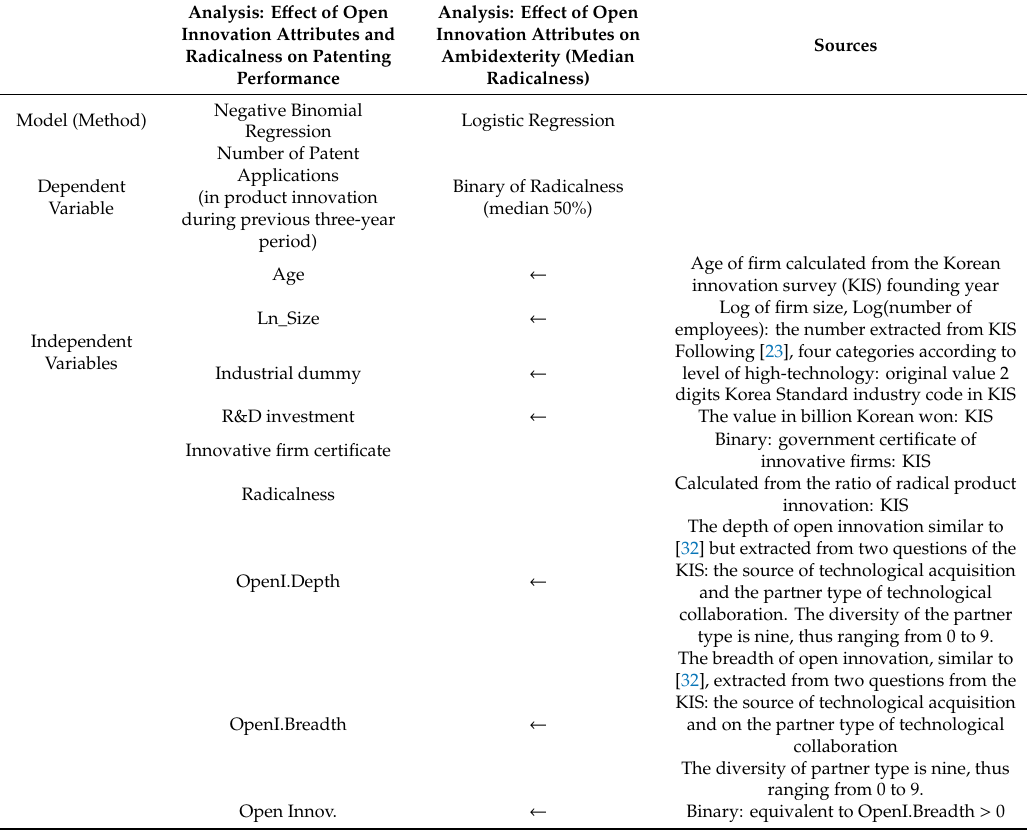
Table 2. Summary of